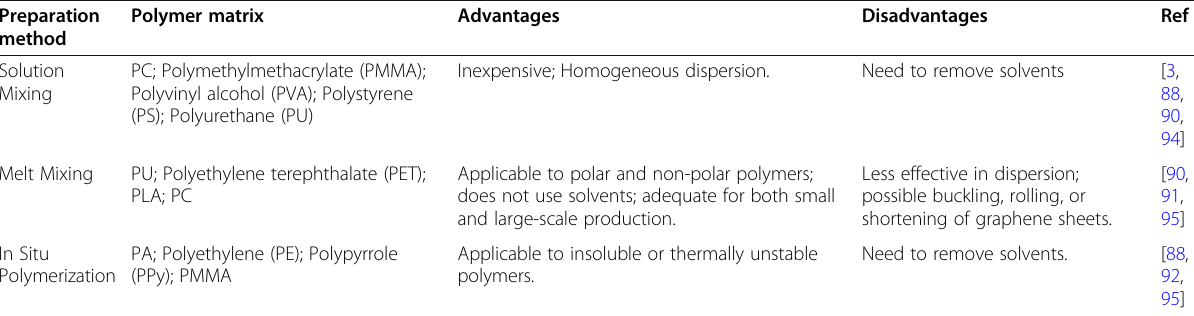
Table 3 Preparation methods of graphene-based composites Preparation Polymer method